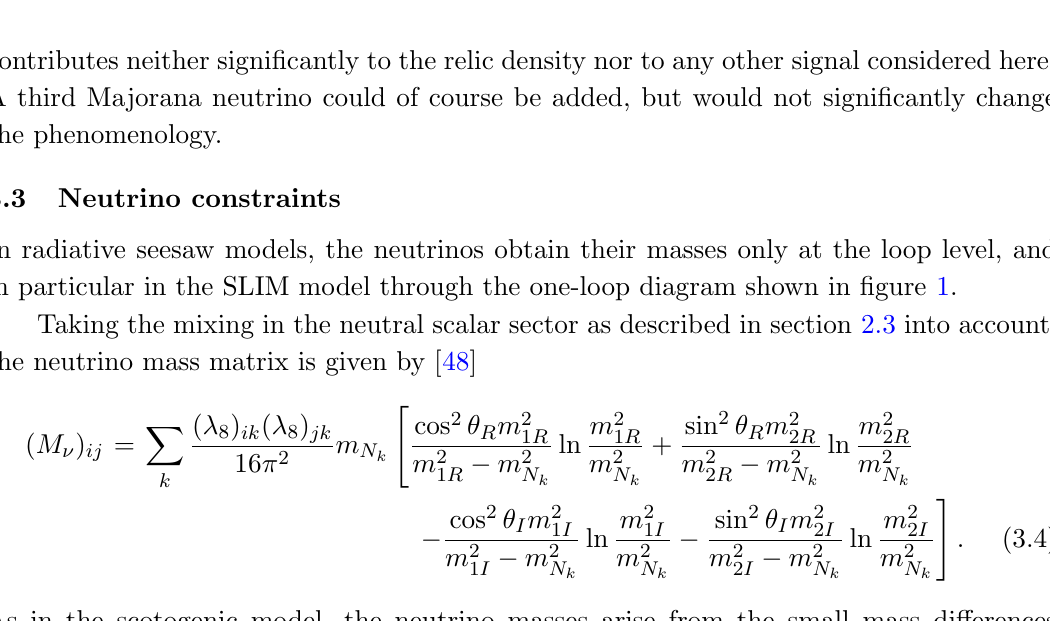
Figure 1 . One-loop diagram leading to the active neutrino mass matrix in the SLIM